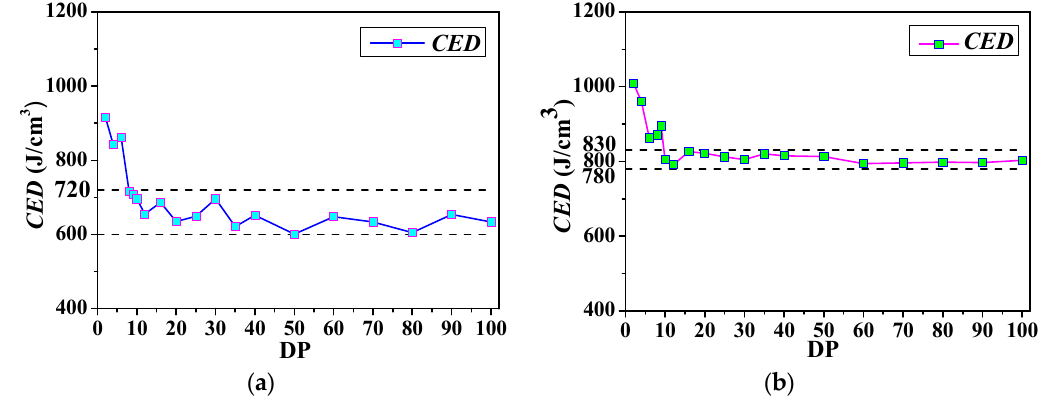
Figure 5. Dependence of CED on DP calculated using ( a ) the COMPASS force field and ( b ) the PCFF force field. Table 2. Average values of E , G , v , and C12-C44 calculated using different force fields.